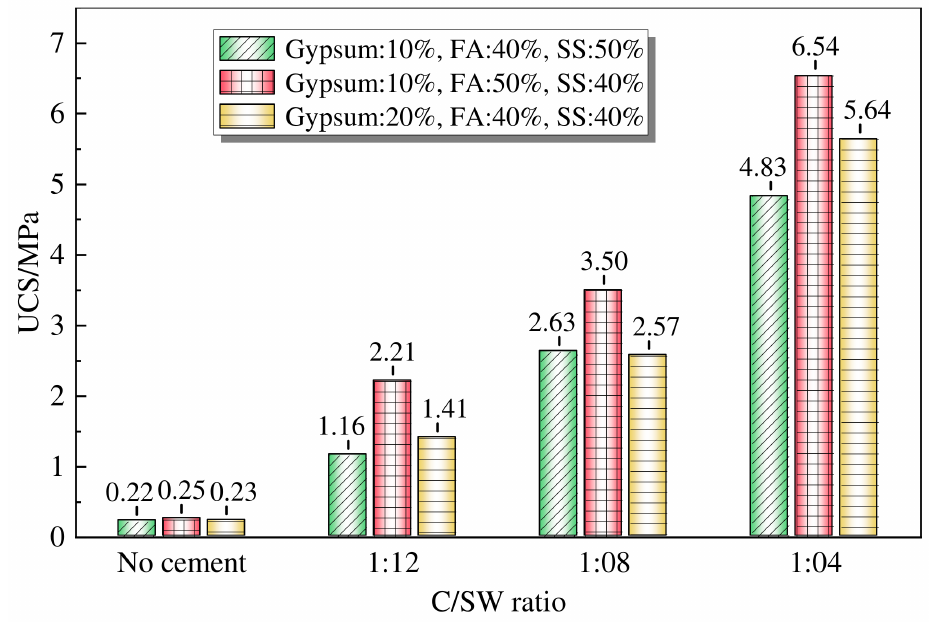
Figure 4. The linear fitting result between the UCS and C/SW ratio